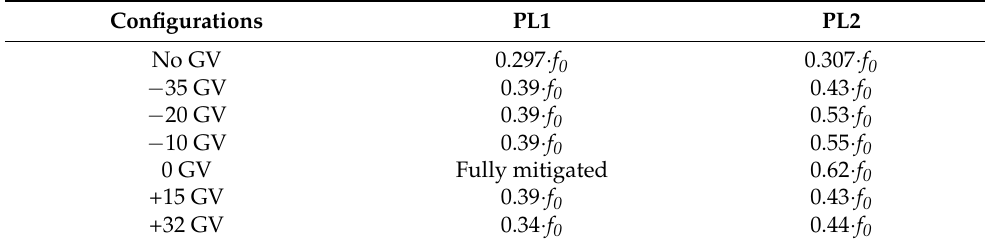
Table 6. RVR frequency shift in the presence of GV system at PL1 and